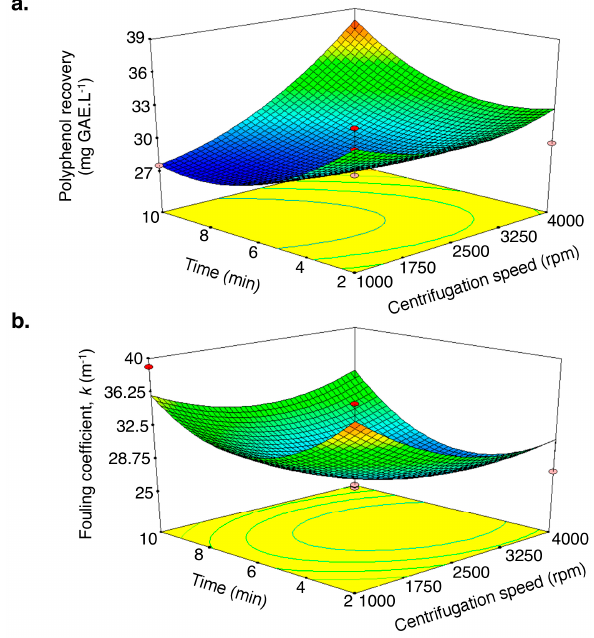
Figure 4. Surface response of polyphenol recovery ( a ) and fouling coefficient ( b ) as a function of centrifugation speed and time.